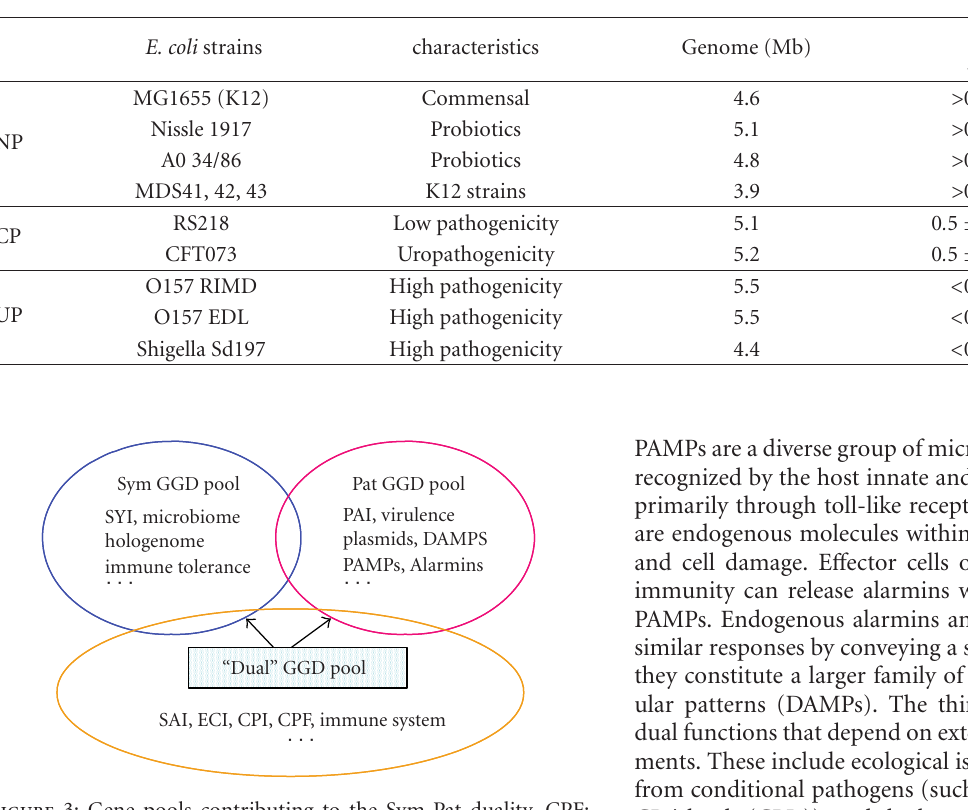
Figure 3: Gene pools contributing to the Sym-Pat duality. CPF: CP factors; CPI: CP islands; ECI: ecological islands; HPI: high pathogenicity islands; PAI: pathogenicity islands; SYI: symbiosis is-